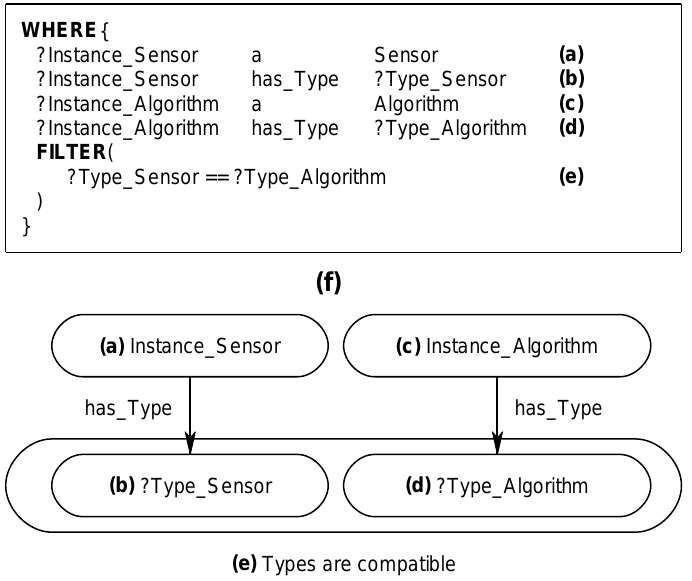
Figure 14. SPARQL WHERE clause (a) The variable Instance_Sensor instantiated to an instance of the class Sensor with the data property (b) has_Type established to the variable Type_Sensor. (c) The variable Instance_Algorithm instantiated to an instance of the class Algorithm with the data property (d) has_Type established to the variable Type_Algorithm. (e) FILTER command comparing Type_Sensor and Type_Algorithm variables for compatibility. (f) Instance